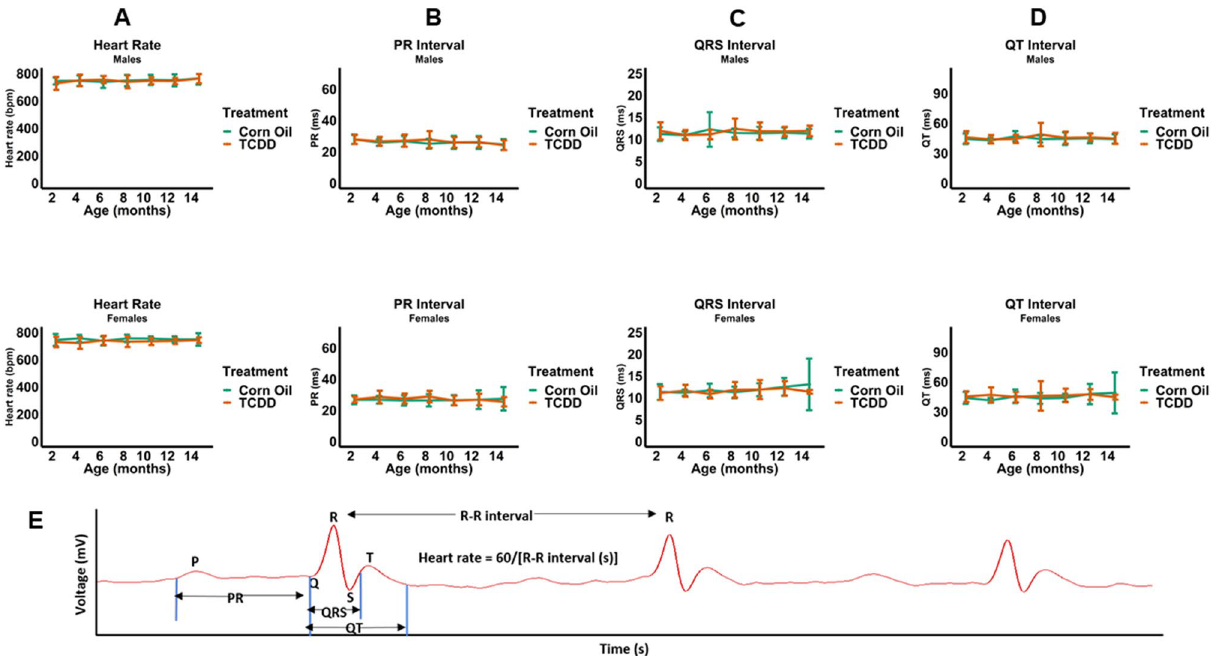
Figure 1. Effect of TCDD on the electrical function of male and female murine hearts over 14 months continuous exposure. Heart rate ( A ) and the electrical parameters PR ( B ), QRS ( C ), and QT ( D ) intervals were assessed. A representative annotated EKG plot from one of the above experiments ( E ) is illustrated. All data are expressed as mean +